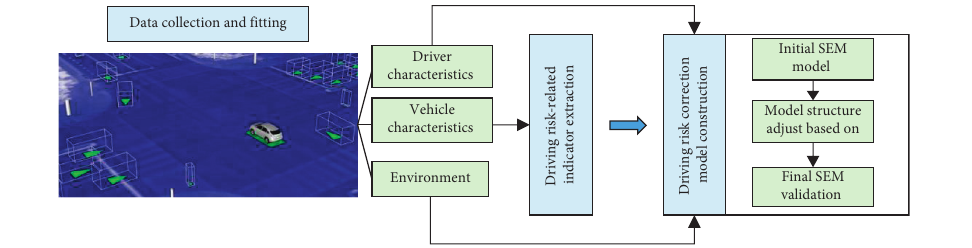
Figure 1: Framework of the methodology. Table 1: Naturalistic driving